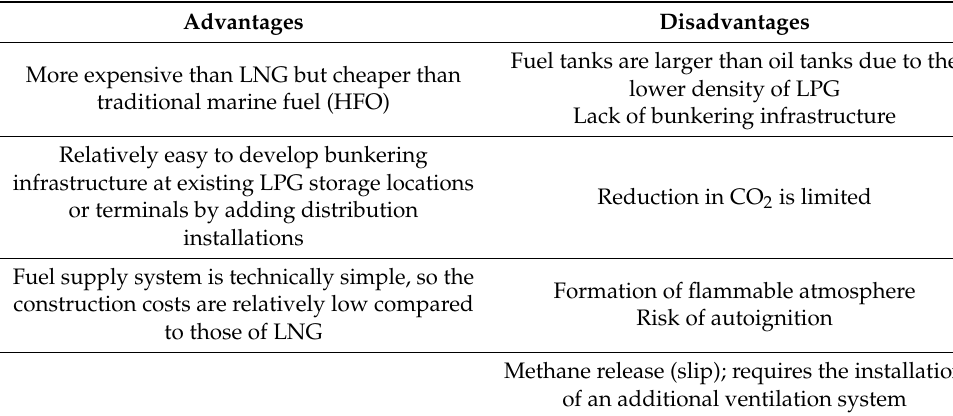
Table 4. An overview of the advantages and disadvantages of hydrogen as an alternative fuel for the